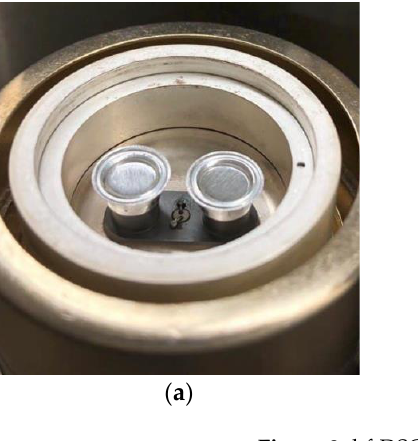
Figure 3. hf-DSC: ( a ) DSC furnace including sample and reference crucibles; ( b ) schematic of crucibles and sensors inside a DSC chamber (personal data).